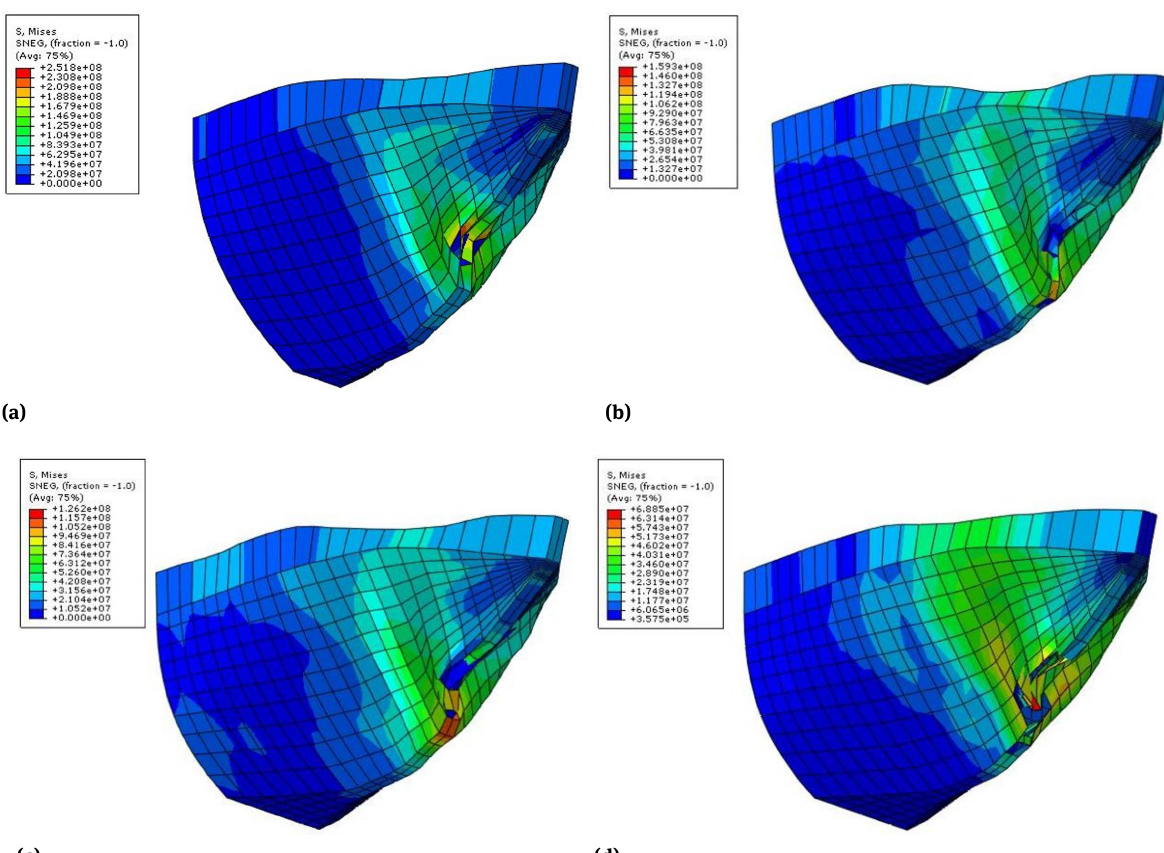
Figure 38: Deformation of hull construction due to impact at 5 knots: (a) Laminate type 1, (b) Laminate type 2, (c) Laminate type 3, (d) Laminate type